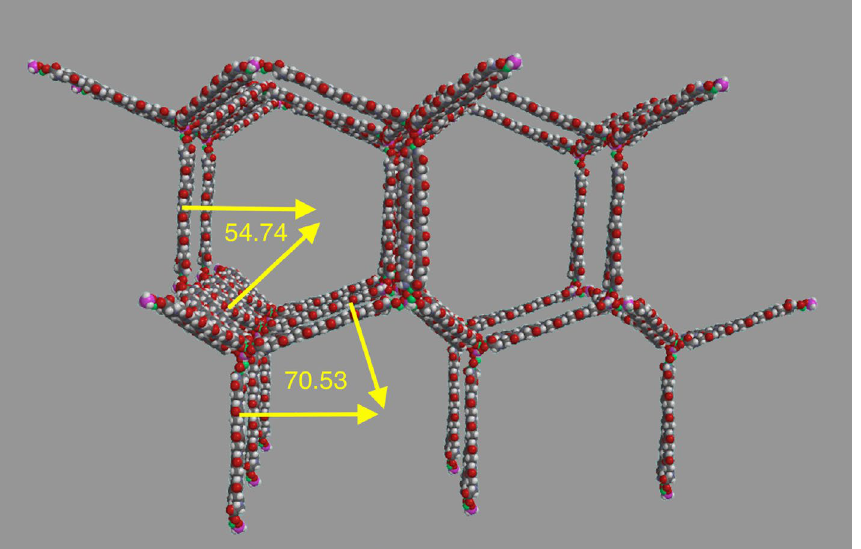
Figure 1. Lattice form of the polymer 14 built of modified core units, here at 1638 Da, linked by silicon atoms. The tetrahedral angles have been confirmed in X-ray scattering. Space filling model. Atoms: hydrogen white, carbon black, nitrogen blue, oxygen red, iron green, silicon pink. Spartan ’20 Version 1.1.5 (220607) (Mac OS